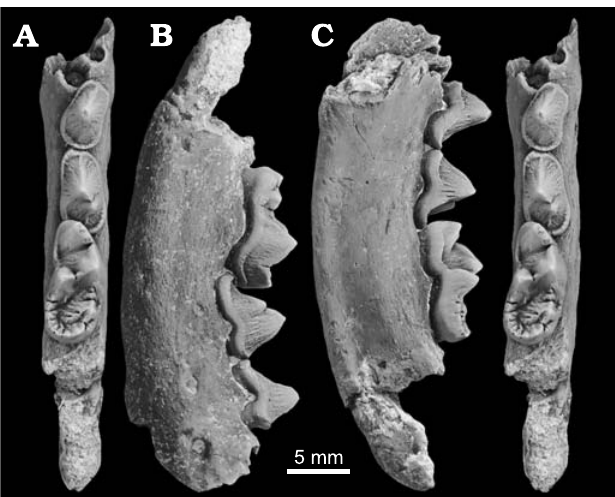
Fig. 7. Mustelid carnivoran Negodiaetictis rugatrulleum gen. et sp. nov. from the Eastgate LF, basal-most unit of the Monarch Mill Formation, Barstovian (Miocene), Churchill County, Nevada, USA. OMNH 54974, holotype right dentary (posteroinferior margin cropped from images) with p3–m1 and alveoli for c and p2 in occlusal ( A , stereopair), labial ( B ), and lingual ( C )